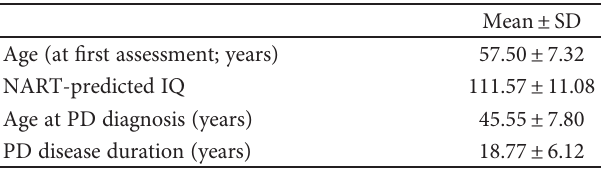
Table 1: Patient